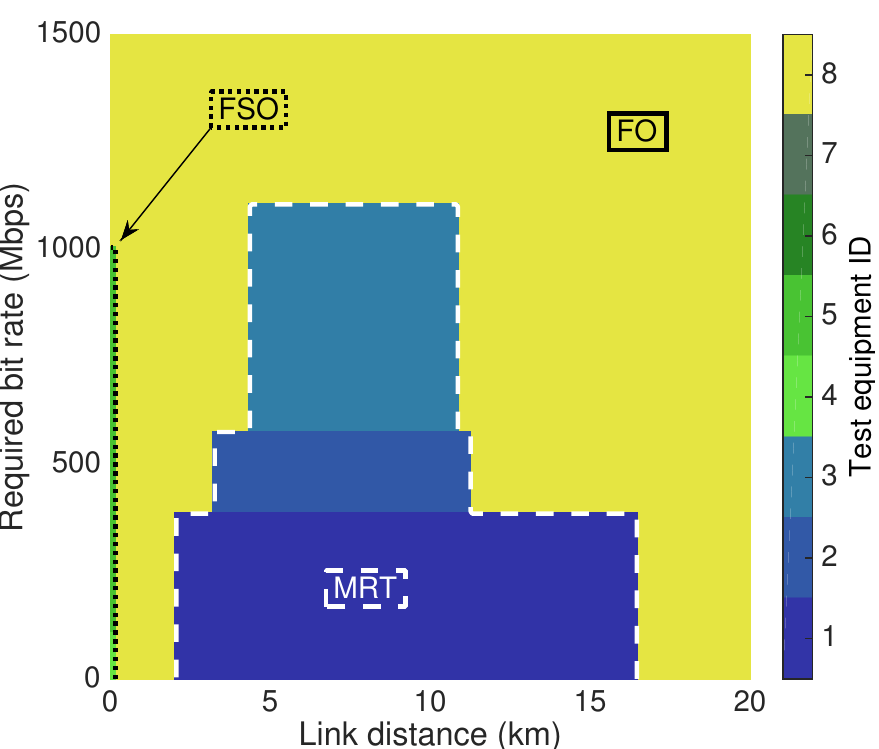
Figure 6. Cost-effective solutions for